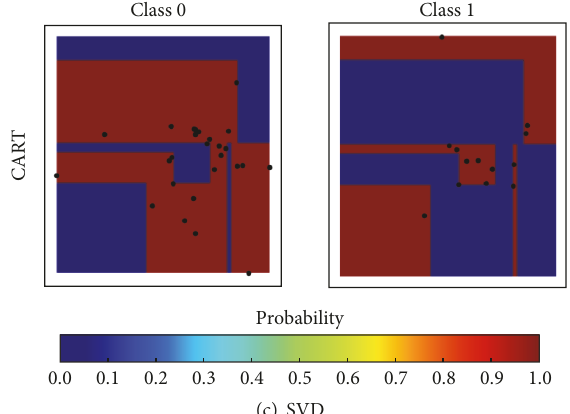
Figure 15: Contour plots of probability surface for classification using the CART for ICA, PCA, and SVD data reduction techniques.